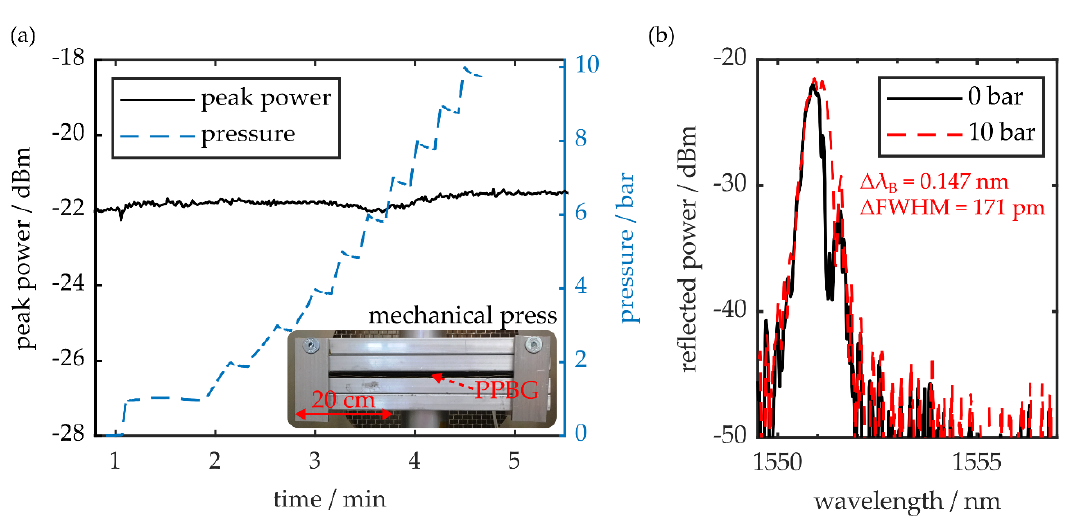
Figure 5. ( a ) Reflected peak power of the PPBG and temperature of the mechanic press during a heated pressure cycle. ( b ) Reflection spectra at room temperature and a pressure of 0 bar temperature of 120 °C and a pressure of 7.5 bar press, cooled back down to room temperature